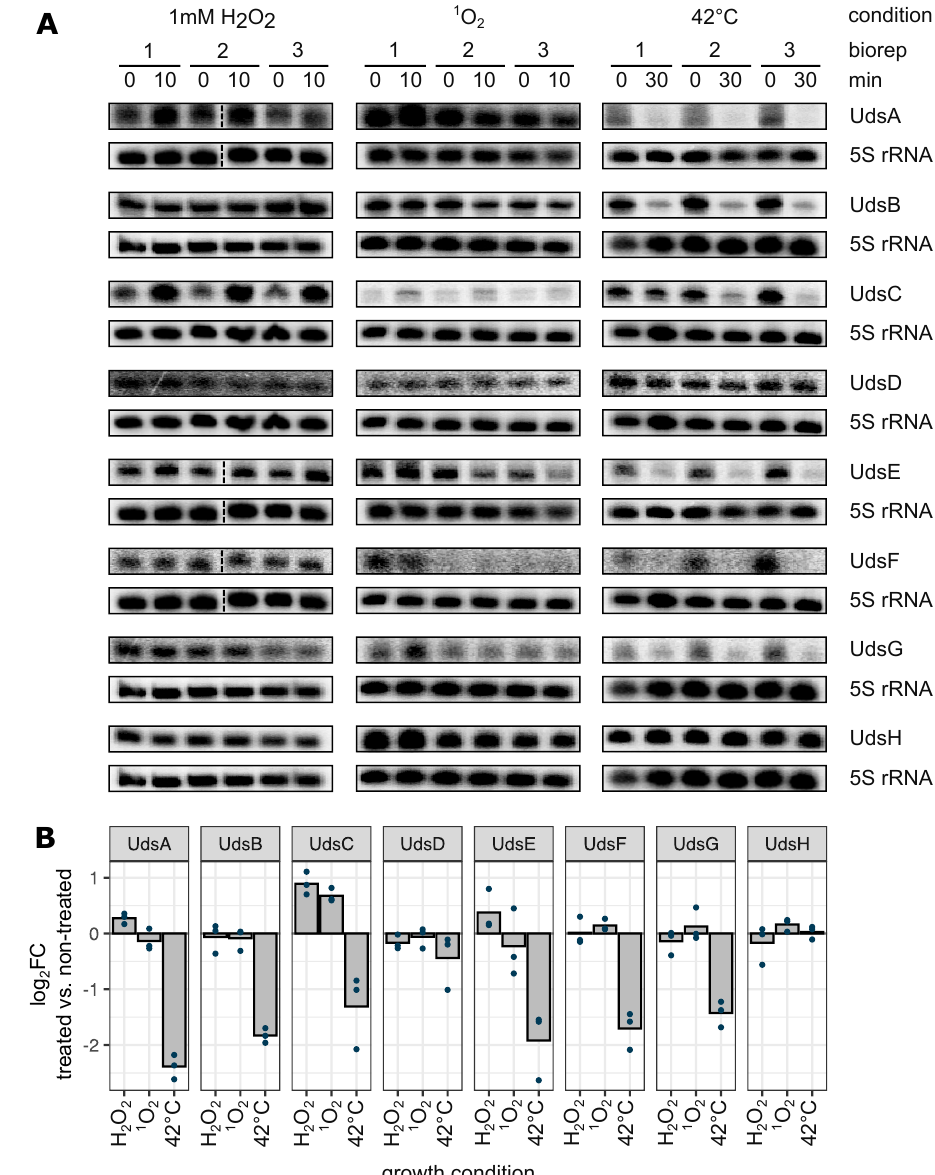
Figure 6. UTR-derived sRNAs are influenced by various stress conditions. ( A ) Exponentially growing R. sphaeroides liquid cultures were exposed to oxidative (1mM H 2 O 2 , 10min), singlet oxygen ( 1 O 2 , 10min) or heat stress (42°C, 30min). Samples for RNA isolation were harvested before and after the indicated time. Northern blot analysis of biological triplicates, 10µg total RNA per lane. 5S rRNA served as loading control. Uncut northern blots are shown in Figures S7 and S8. ( B ) log 2 fold changes (treated vs. non-treated) were computed based on the northern blot data. Every dot represents one biological replicate. n =